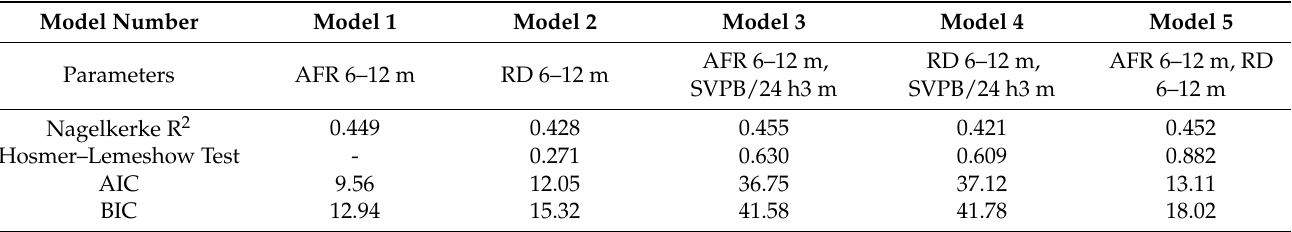
Table A6. Multivariate models assessment for AFR over 12